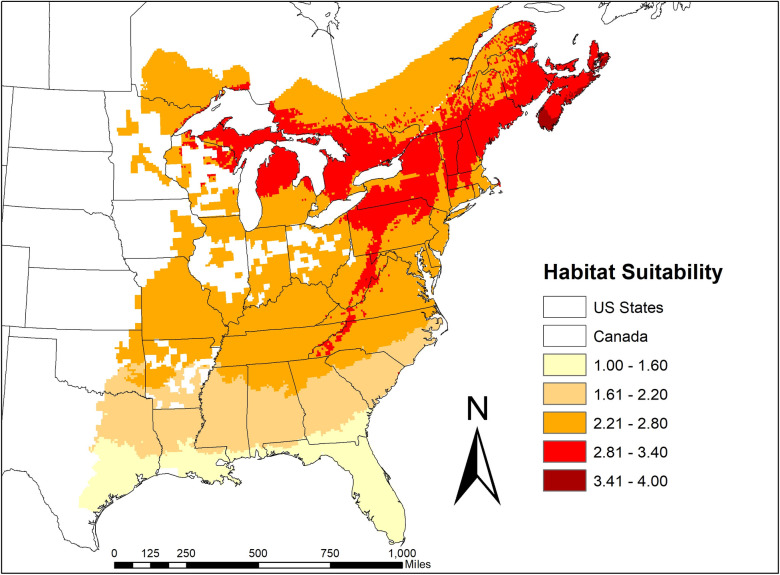
Invasion risk of Bsal into Notophthalmus viridescens populations in North America, adjusting for temperature-dependent susceptibility.Red indicates increasing risk, while light-colored areas indicate low invasion risk. Regions shaded white are outside of the N. viridescens range.